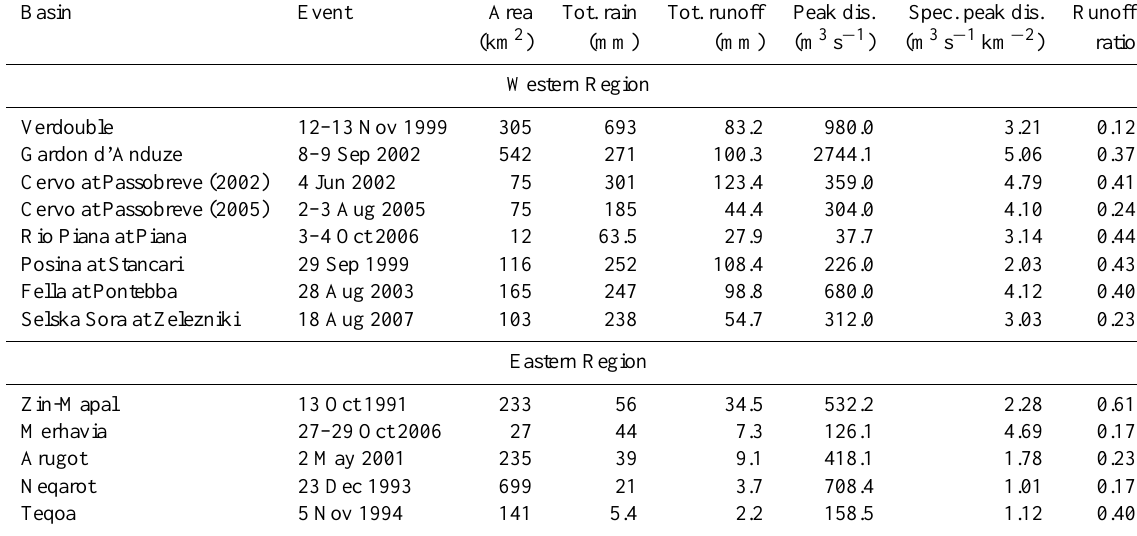
Table 2. Rainfall and runoff properties for selected events in the two Mediterranean